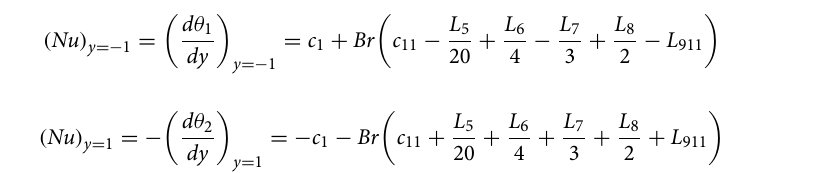
Derived quantities. Nusselt number: It is the rate of heat transfer at the right & left plate.